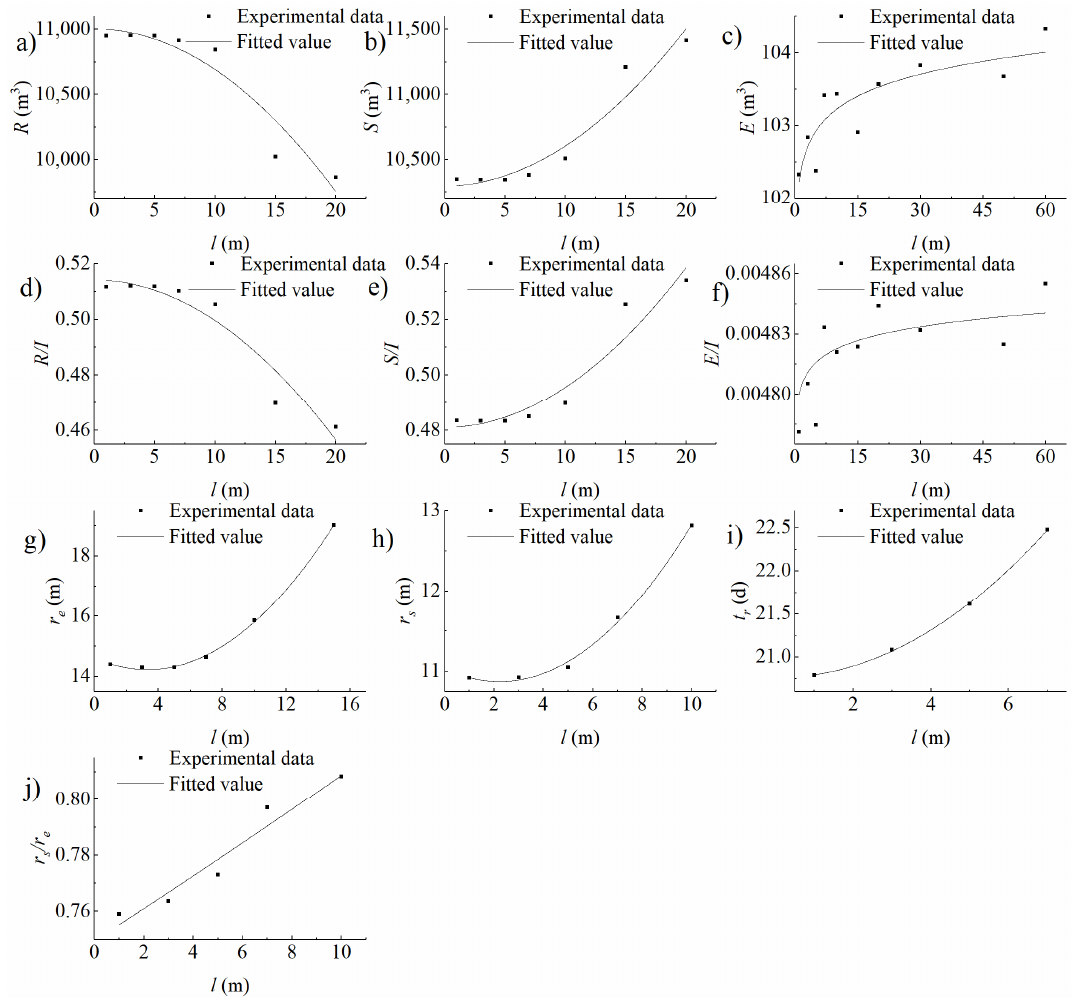
Figure 12. The variations with an increment in l when the depth is 55 m. (( a ) variation of R; ( b ) variation of S; ( c ) variation of E; ( d ) variation of R/I; ( e ) variation of S/I; ( f ) variation of E/I; ( g ) variation of r e ; ( h ) variation of r s ; ( i ) variation of t r ; ( j ) variation of r s /r e .).